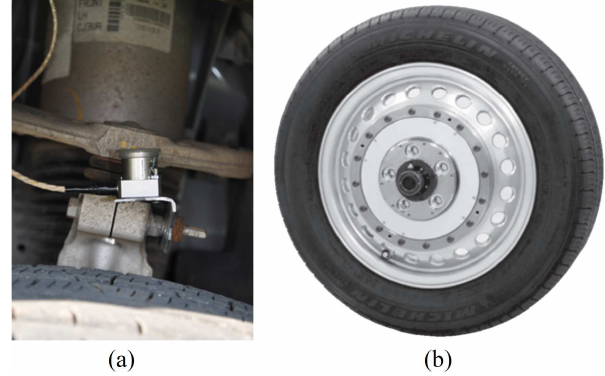
Fig. 16. (a) Accelerometer on axle. (b) Wheel torque trans-